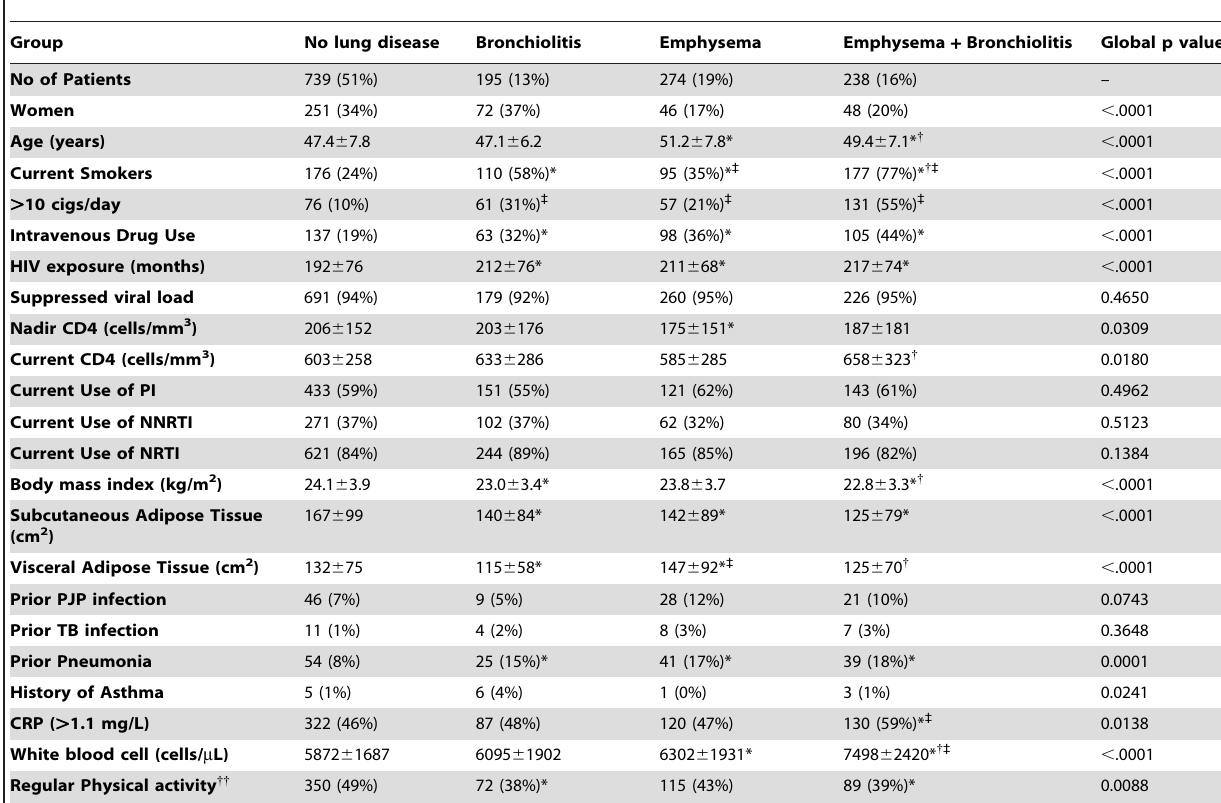
Table 1. Clinical Characteristics of the 1,446 Consecutive Subjects With HIV Infection According to COPD Changes on CT Scans.